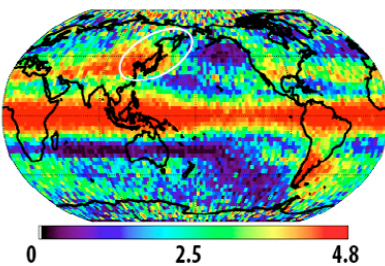
Figure 3. Annual mean of the potential energy in Jkg − 1 averaged across the whole vertical profile for 2007–2010 (non-linear colour scale